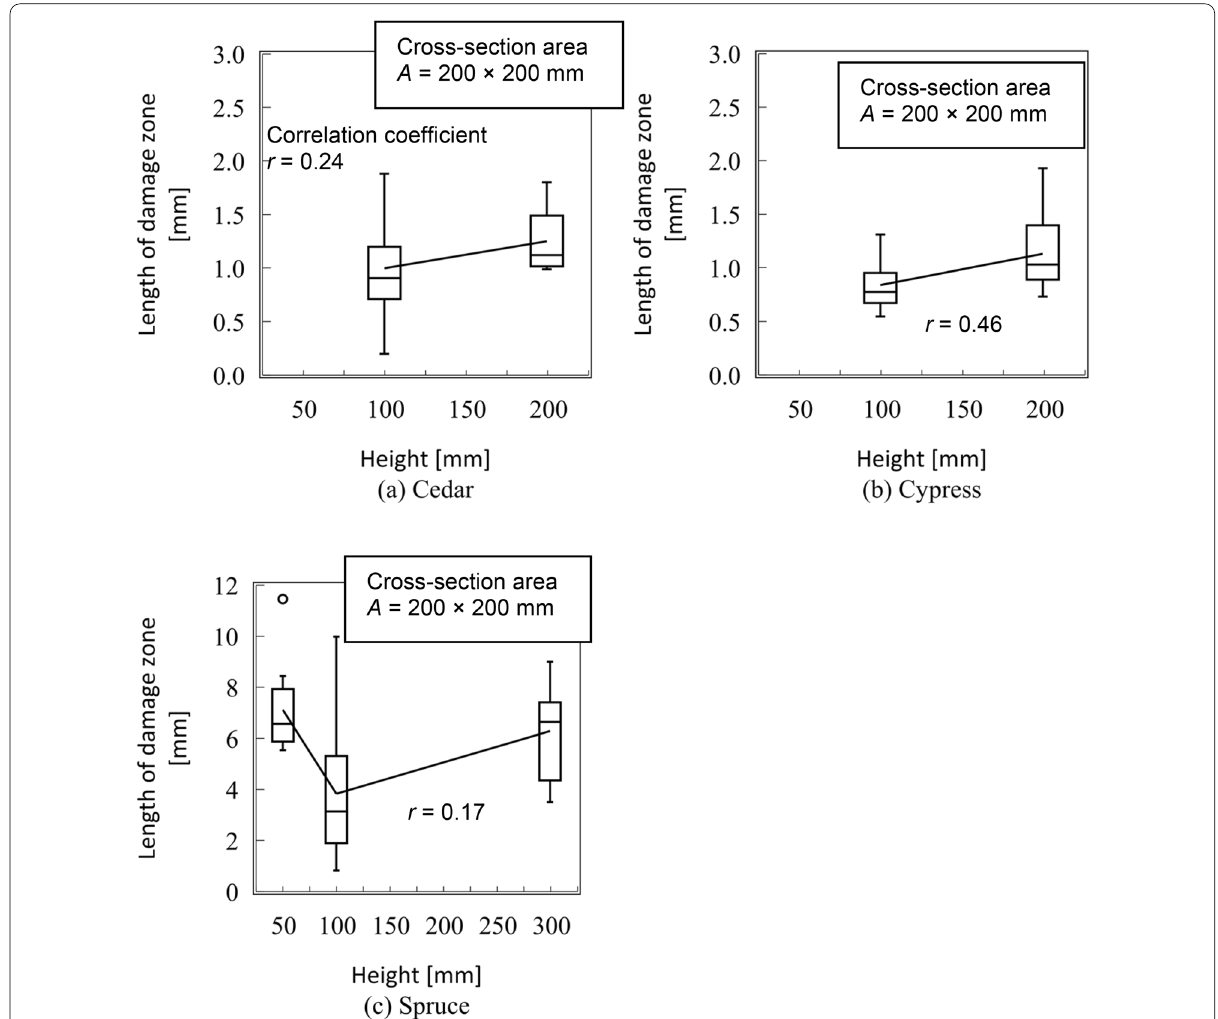
Fig. 12 Length of damage zone of specimens of varying